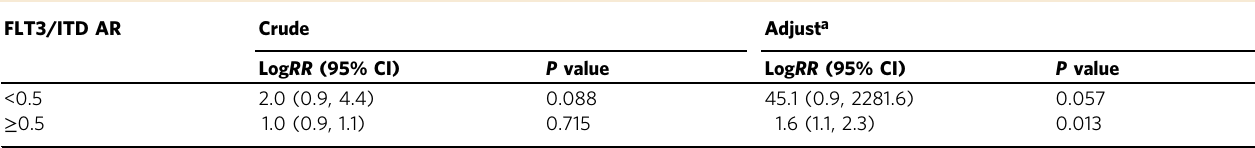
Table 2 Threshold effect analysis of the association between FLT3/ITD AR and risk of all-cause mortality using piece-wise linear